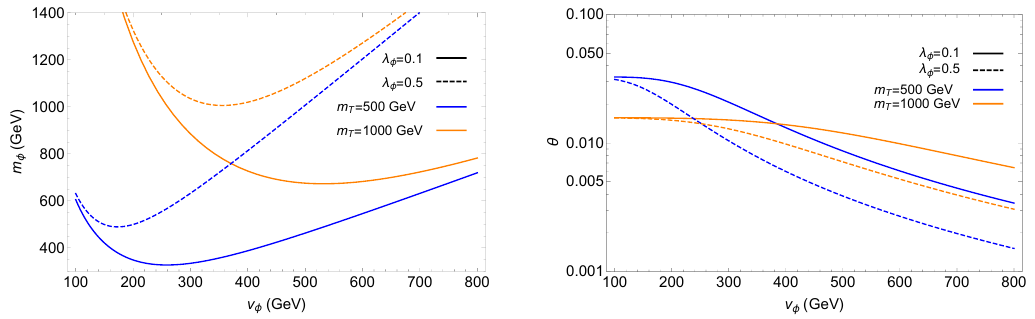
Figure 1 . On the left (right) we plot the mass (mixing angle with the Higgs) of the singleton scalar for twin top mass of 500 (1000) GeV in blue (orange). The quartic coupling (cid:21) (cid:30) is 0.1 (0.5) for the solid (dashed) lines. The mass is typically at least a few hundred GeV and can be much heavier. The the mixing angle is always